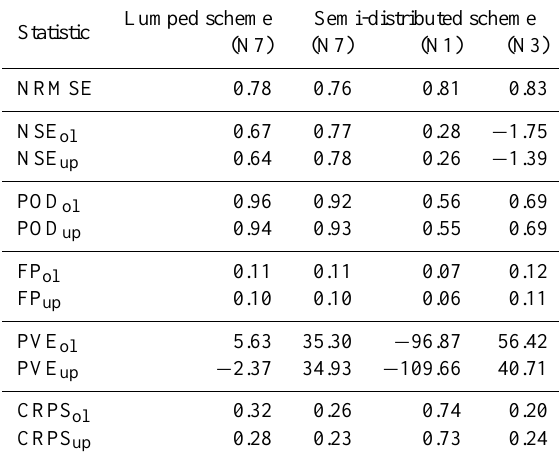
Table 4. SM-DA evaluation statistics calculated at the catchment outlet (N7) and at the inner catchments (N1 and